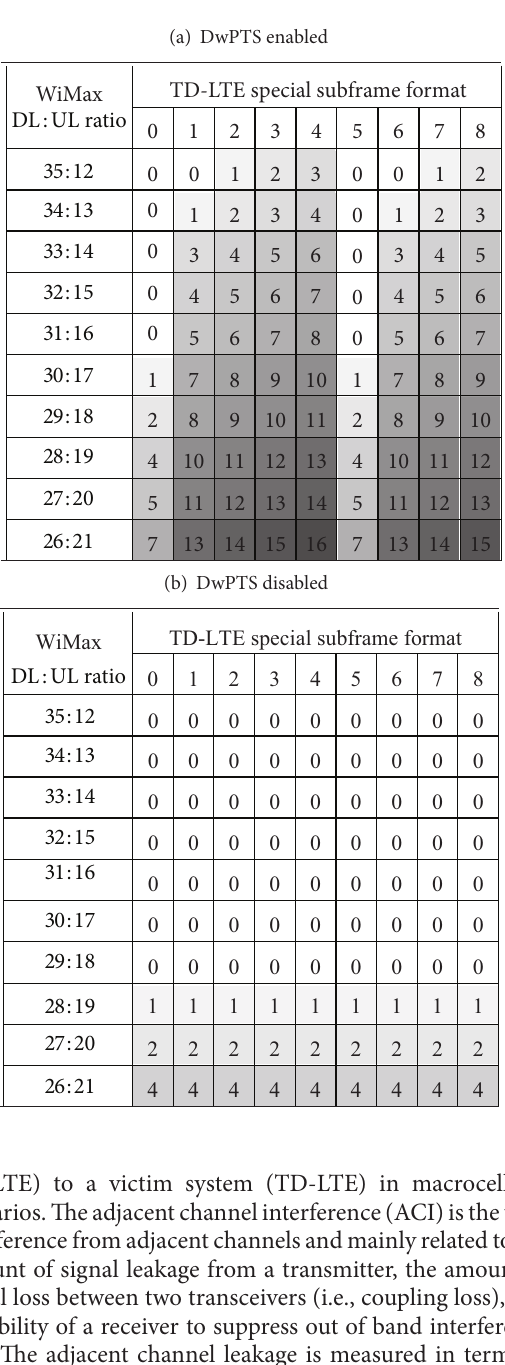
Table 5: Number of TD-LTE symbols overlapped with 10MHz WiMax (TD-LTE configuration